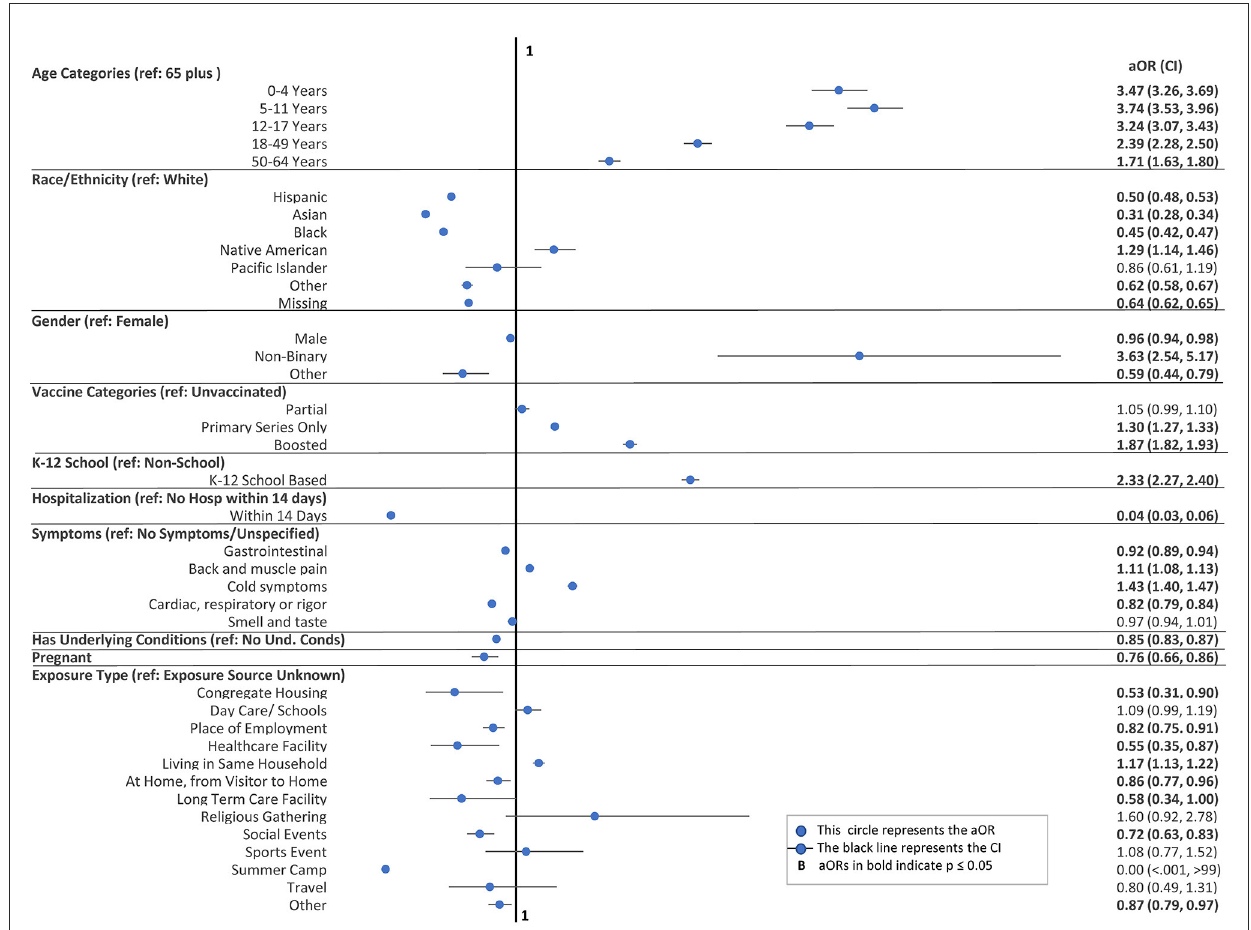
FIGURE4 Multivariate logistic regression: adjusted odds ratios (aOR) and confidence intervals (Cl) for home-tests-only vs. laboratory-test-only b . b The following variables adjusted in the model are not displayed above: month, county, gender missing, and some exposure sources (political rally/gathering, summer camp, and not